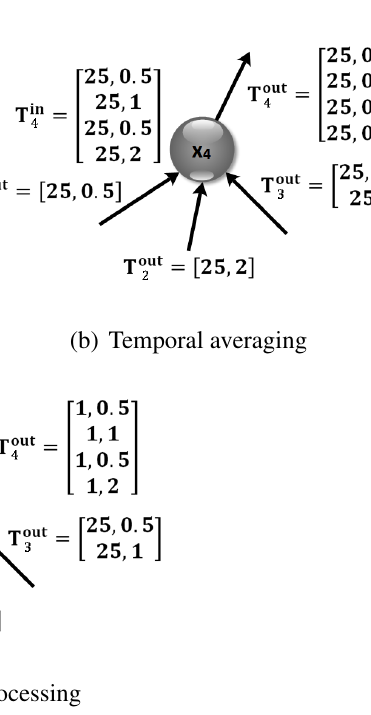
Figure 3. Examples of data processing in node 4 that receives input traffic from nodes 1 – 3